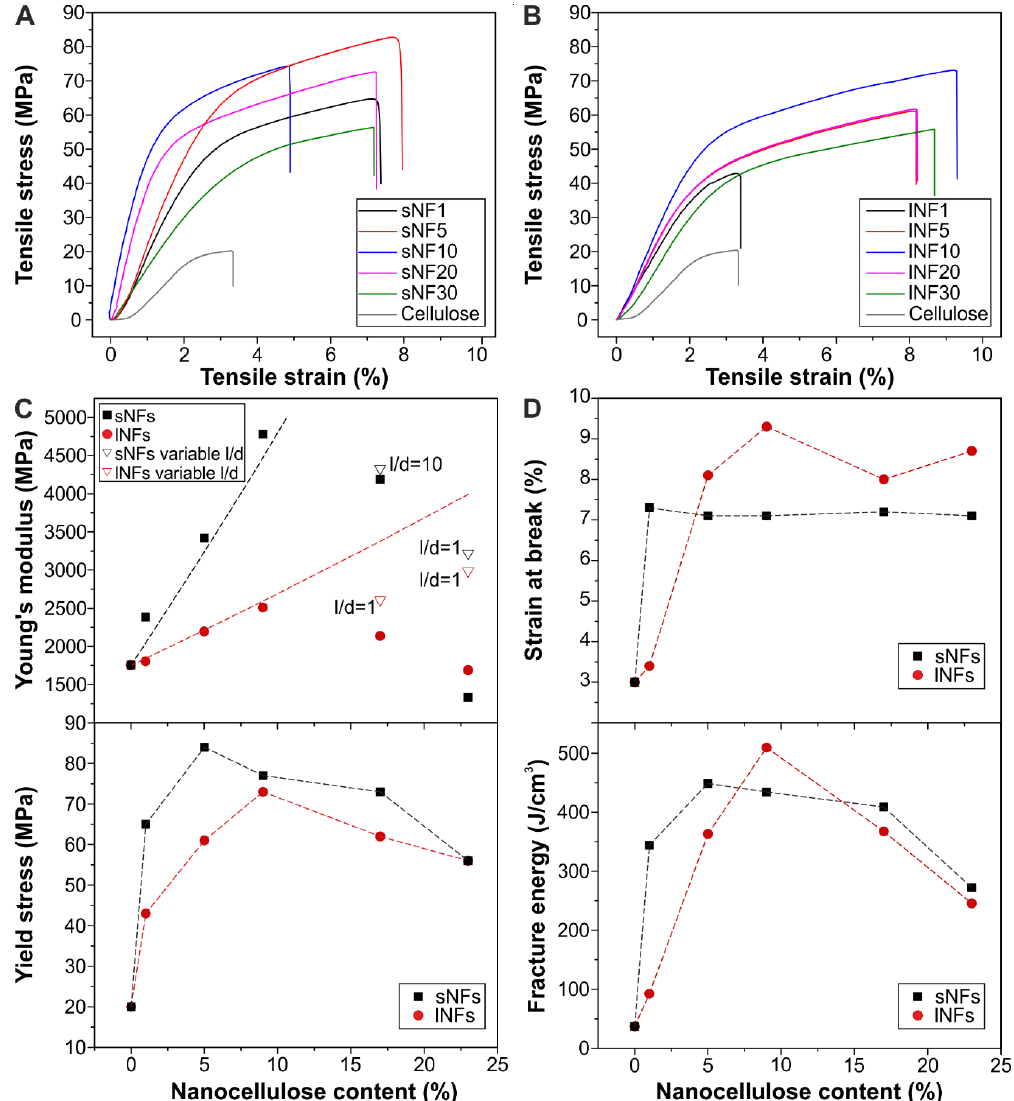
Figure 4. (A , B) Stress – strain curves of all -cellulose nanocomposites prepared with short and long nanofibers, respectively. ( C ) Experimental Young’s modulus as a function of nanocellulose content; the dashed line indicates the analytical model for lNF composites. As the nanocellulose content is increased, the model does not fit the experimental data, even if aggregation is accounted for as a variation of the aspect ratio (hollow points). ( D – F ) Yield stress, strain at the break, and fracture energy values as a function of nanocellulose content.